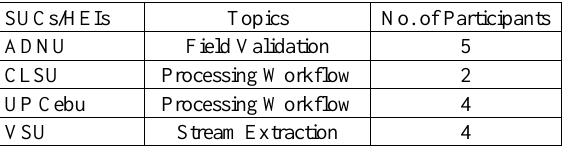
Table 6. Joint fieldworks conducted by PHD